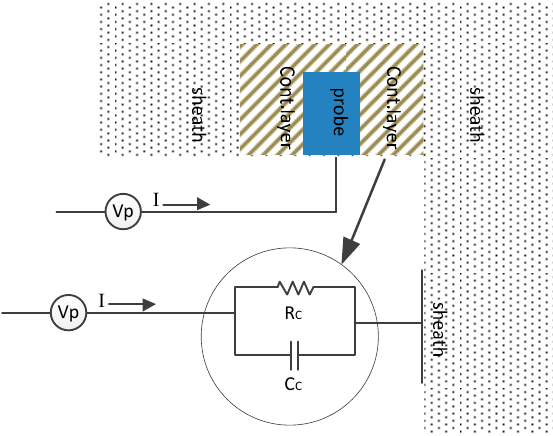
Figure 6. Equivalent circuit of the electrode contamination.